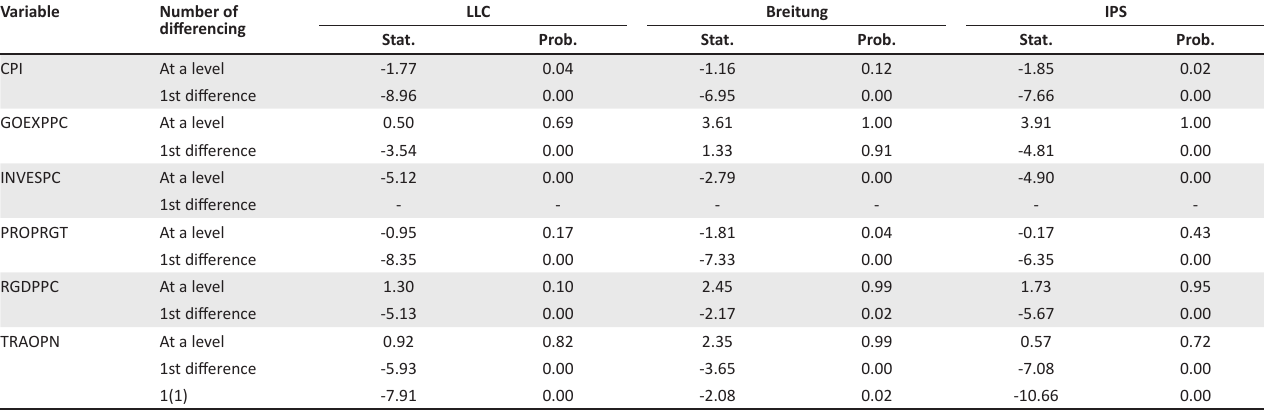
TABLE 1: Unit root